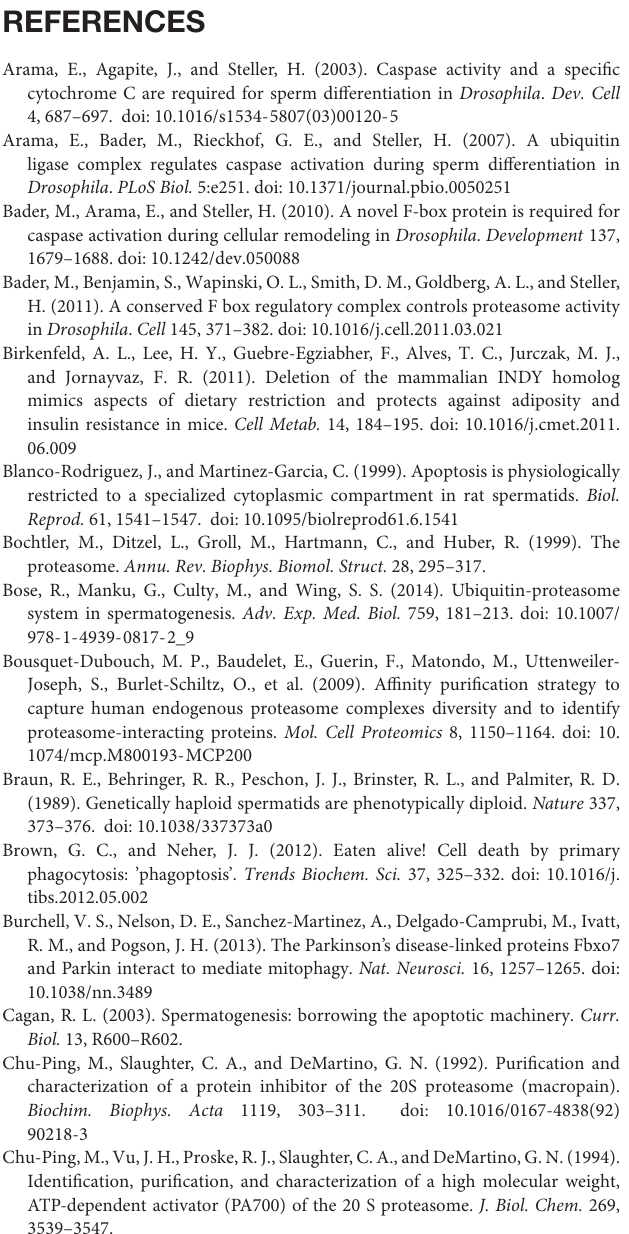
seminiferous tubules, which is highlighted in these images due to the long exposure time. In particular, at stage X-XI the negative control showed no signal in elongating spermatid nuclei and minimal staining in spermatocyte cytoplasm (compare to Figure 6 lower middle panel). Similarly, at stage V-VI, there was TABLE S1 | Details of antibodies used in this study. TABLE S2 | All tubules were examined for a complete testis cross section for three males from each genotype. sgl, tubules with one or more singleton spermatid heads located at the basement membrane. gy, tubules with one or more “graveyards” consisting of 2 or more mislocalised spermatids lying within the same Sertoli